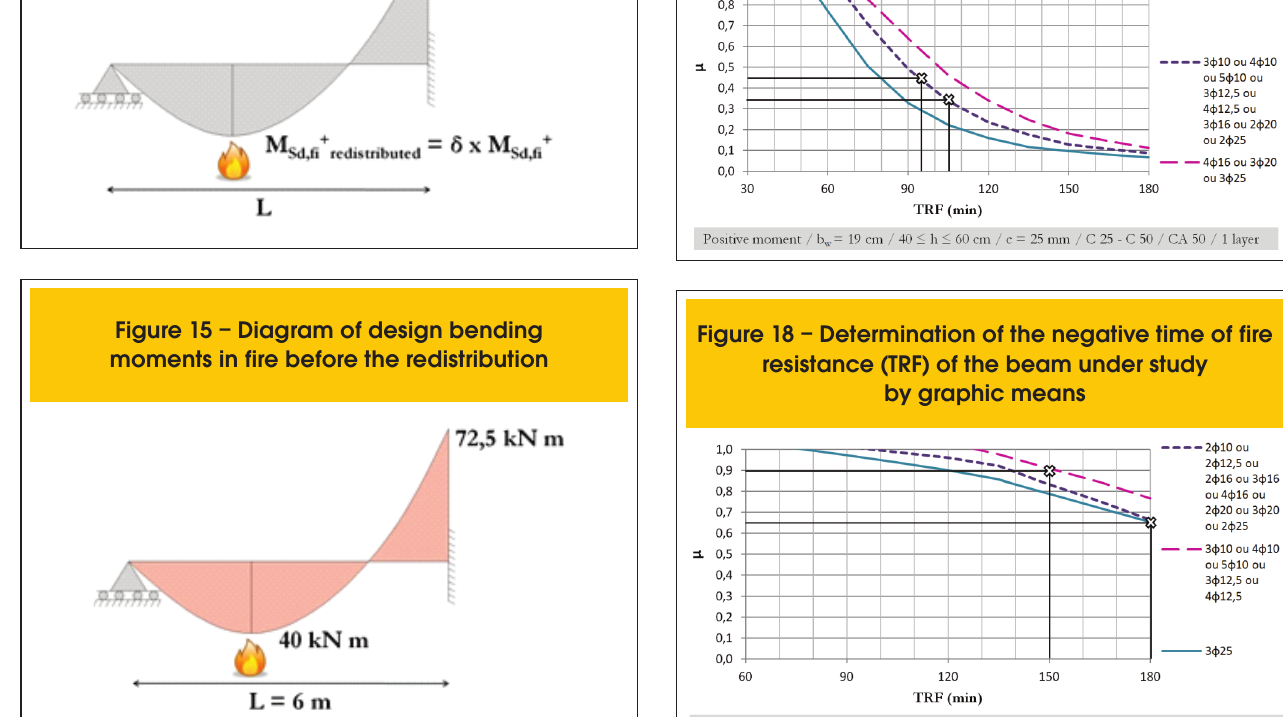
Figure 17 – Determination of the positive time of fire resistance (TRF) of the beam under study by graphic means